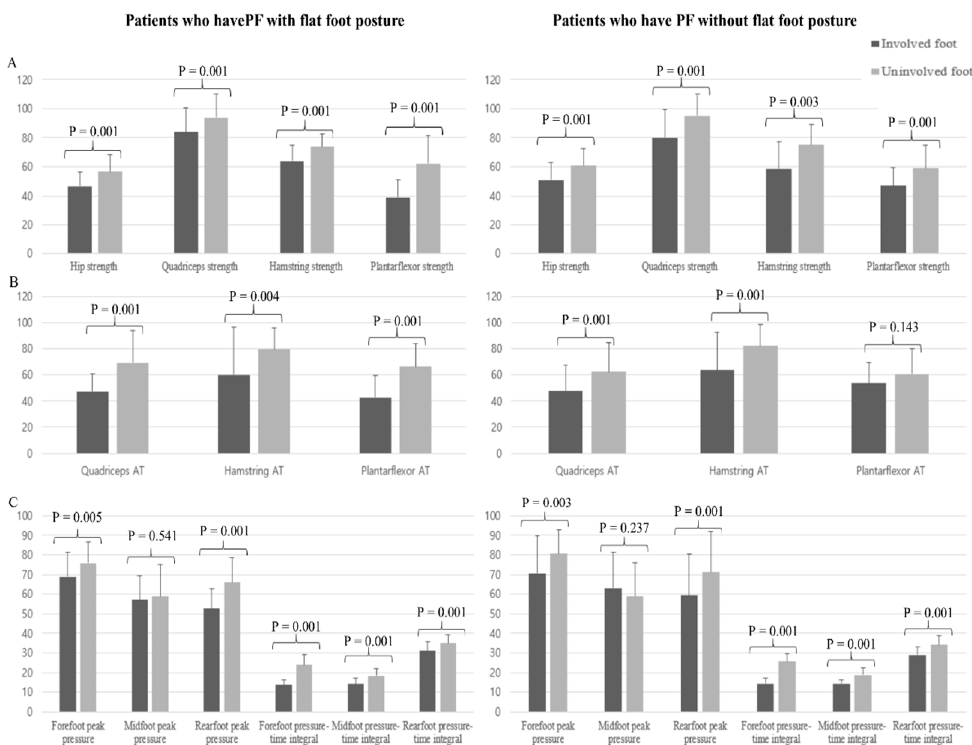
Figure 2. Lower extremity muscles performance [strength ( A ) and AT ( B )] and foot pressure ( C ) in patients who have PF, with and without a flat foot posture. PF, plantar fasciitis; AT, acceleration time.